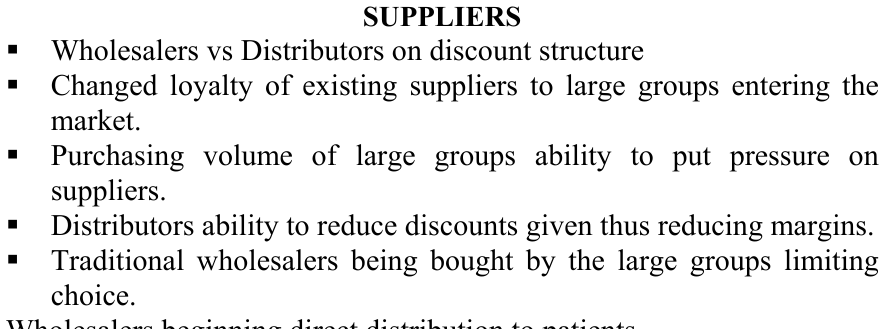
The five forces model for the retail pharmacy market